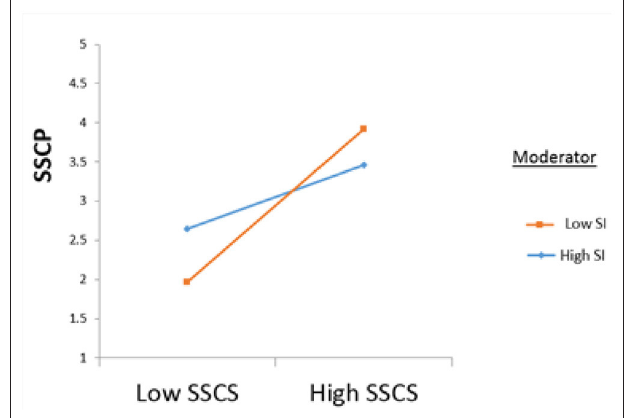
FIGURE 3 | Interaction Effect SSCS*SI → SSCP.